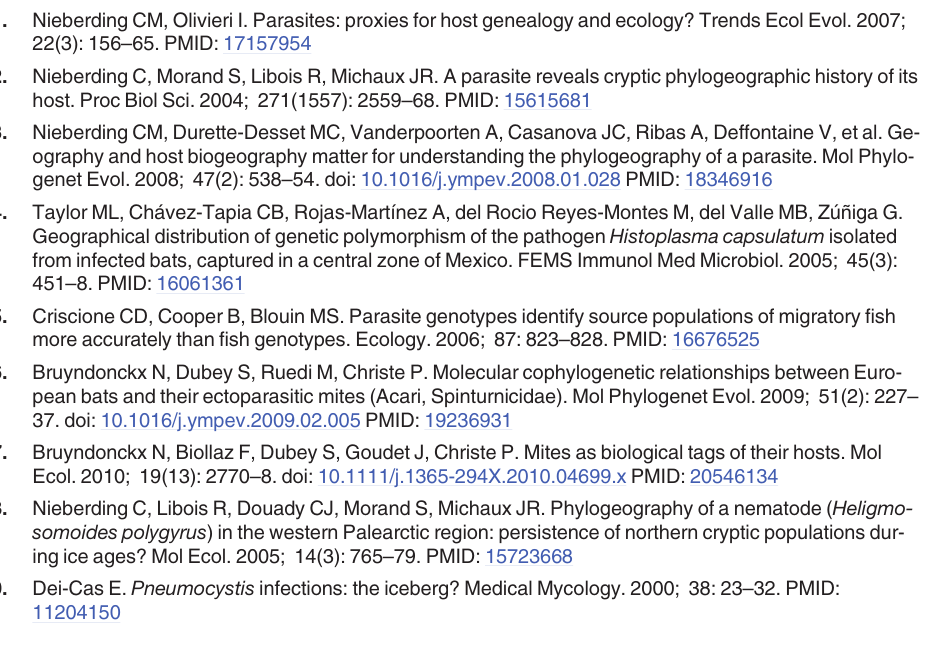
percentages displayed above the branches are the frequencies with which a given branch ap- peared in 1,000 bootstrap replications. S4 Fig. MB phylogenetic tree depicting relationships between Pneumocystis organisms iso- lated from A . sylvaticus of different trapping locations. MB are inferred from the combined mitochondrial small subunit (mtSSU) and large subunit (mtLSU) rRNA sequences. The per- centages displayed above the branches are the frequencies with which a given branch appeared in 1,000 bootstrap replications. S5 Fig. MP phylogenetic tree depicting relationships between Pneumocystis organisms iso- lated from A . sylvaticus of different trapping locations. MP is inferred from the combined mitochondrial small subunit (mtSSU) and large subunit (mtLSU) rRNA sequences. The per- centages displayed above the branches are the frequencies with which a given branch appeared in 1,000 bootstrap replications. (cid:1) Bootstrap values below 50% are